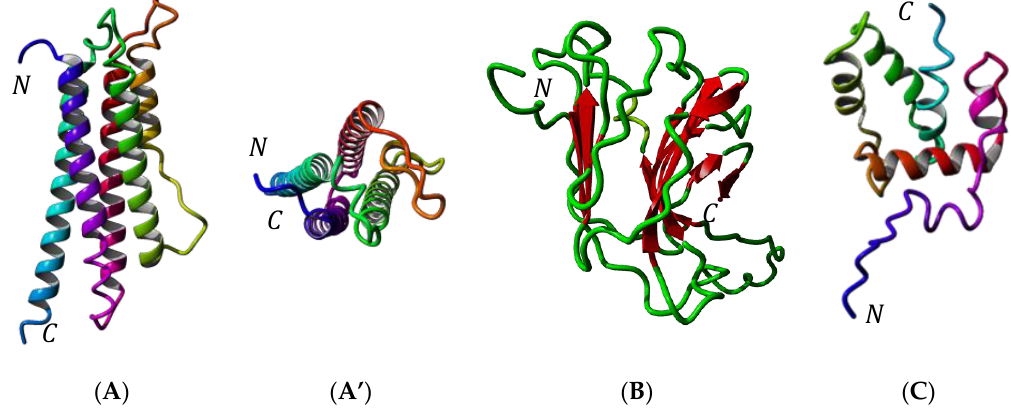
Figure 3. ( A ) Ribbon diagram of apolipophorin-III of Tenebrio molitor (sagital view). Alpha-helices numbered α 1– α 5 are di ff erently colored. N and C correspond to the N - and C -terminus of the polypeptide chain, respectively. ( A’ ) Ribbon diagram of apolipophorin-III of T. molitor : upper view showing the arrangemernt of α -helices around a central hydrophobic pocket. ( B ) Ribbon diagram of the larval cuticlar protein (LCP) of T. molitor , built up from the association of two antiparallel bundles